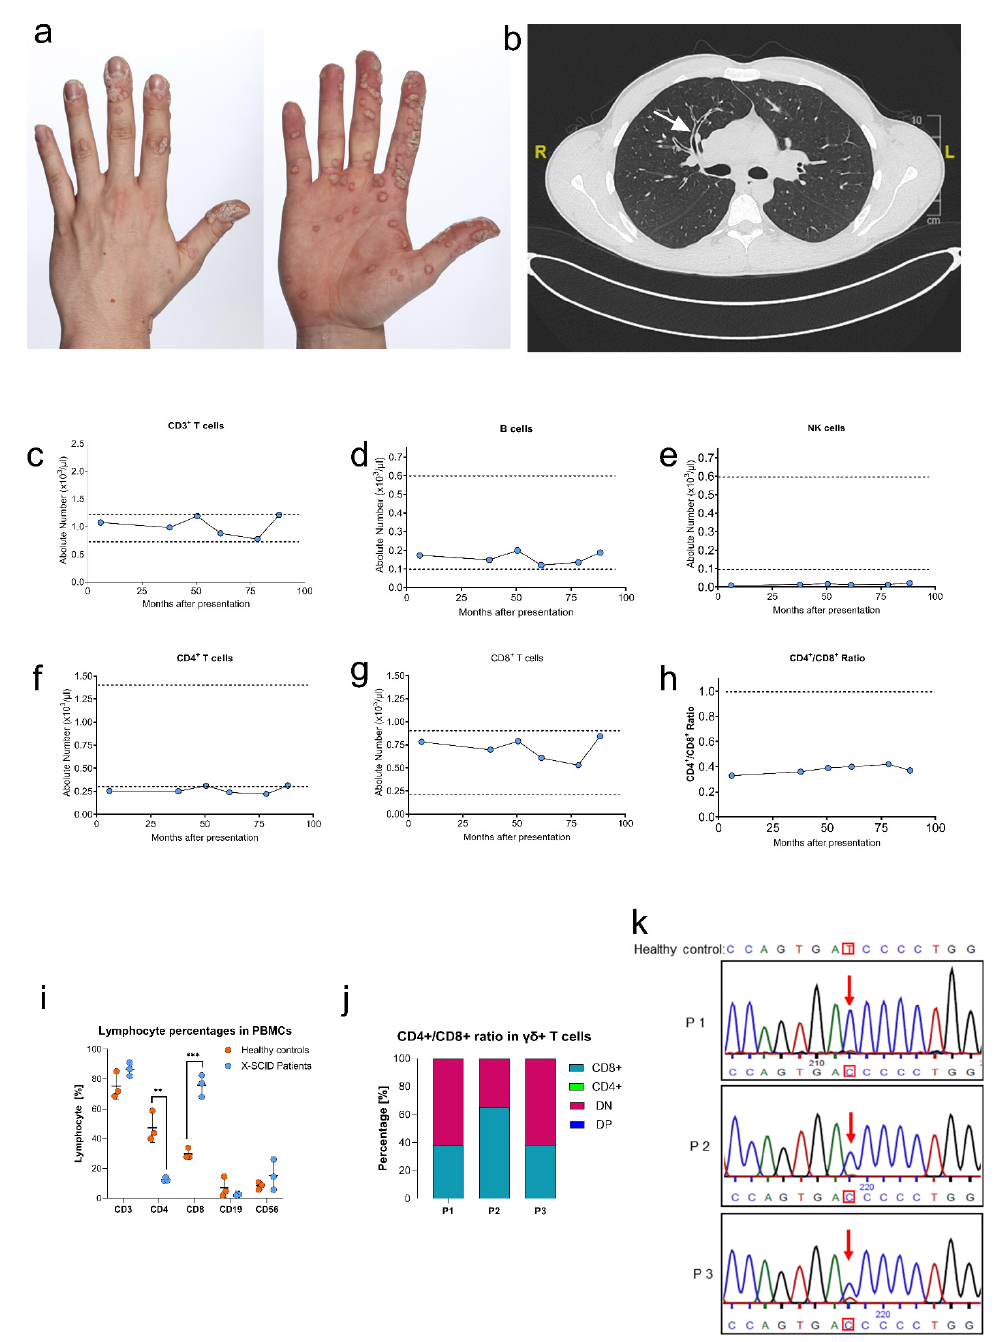
Figure 1. Clinical presentation of patient 1 (P1): ( a ) Hand warts; ( b ) Chest CT (19-year-old) with features of respiratory infections. Long-term immunological status of P1: absolute number of CD3 + T cells ( c ), B cells ( d ), NK cells ( e ), CD4 + T cells ( f ), CD8 + T cells ( g ), and CD4 + /CD8 + ratio ( h ). Dotted lines indicate upper and lower limits of normal for corresponding age, for CD4 + /CD8 + ratio is inverted. Lymphocyte subpopulation ratios in PBMCs ( i ): The three patients had lower proportions of CD4 + T cells than healthy controls ( n = 3, p ** < 0.01), while the percentage of CD8 + T cells were significantly higher than healthy controls ( p *** < 0.001). CD4 + /CD8 + ratio in γδ +-T cells ( j ): Compared with the reference range of double negative (DN) (>70%), CD8 + (30%) and CD4 + (<1%) in γδ T lymphocytes of human peripheral blood T cells, the percent of CD8 + /TCR γδ T cells was above the normal range. Genetic analysis ( k ): DNA sequence analysis in whole blood from a healthy control and the three patients. The mutated nucleotide C replaced the wild-type